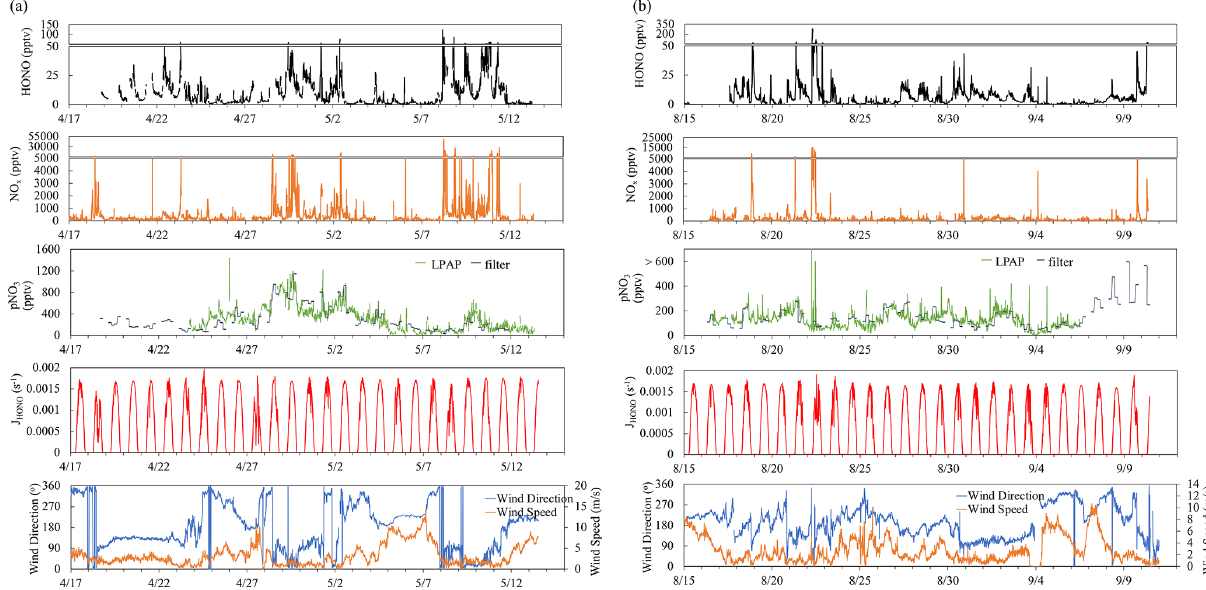
, HONO photolysis rate constant ( J HONO ), wind direction, and wind speed , pNO filter 3 3